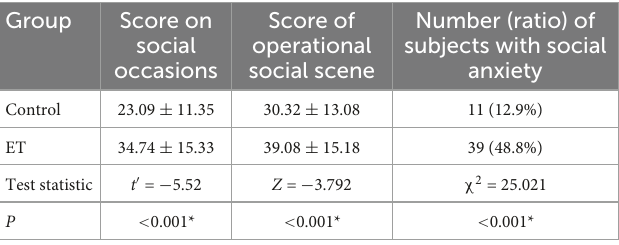
Group Score on social